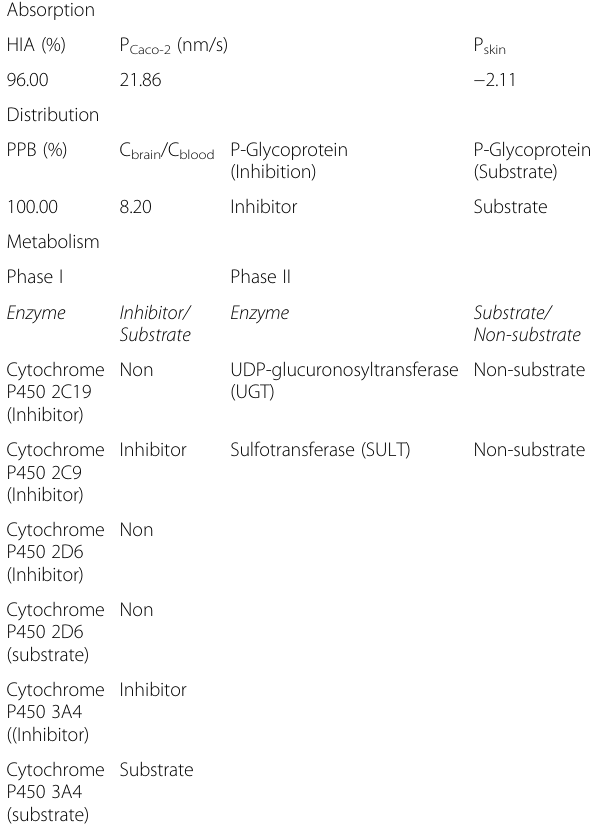
Table 7 Absorption, distribution and metabolism of betulinic acid Absorption HIA (%)